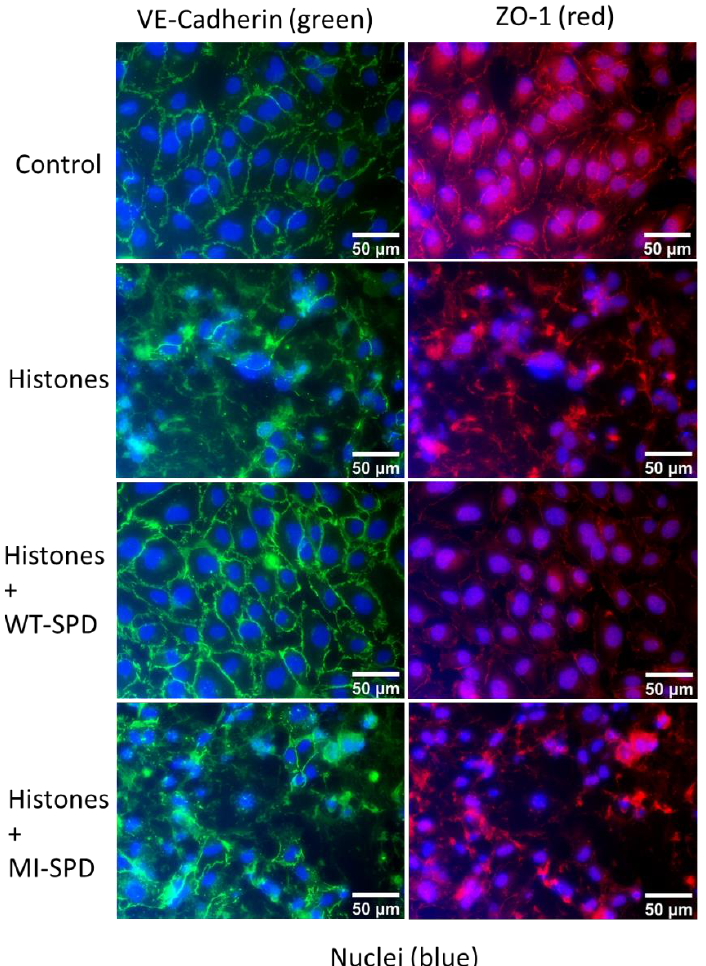
Figure 3. Effect of SPD–FSAP on the pattern of junctional proteins. HUVEC were treated with 50 µ g/mL histones and/or 10 µ g/mL WT–SPD–FSAP for 24 h before fixation. MI–SPD–FSAP was used as a negative control. Immunofluorescent staining of the junction protein VE-cadherin (green), ZO-1 (red), and nuclei (blue). Relative IgG was used as control. Representative images from 3 independent experiments.